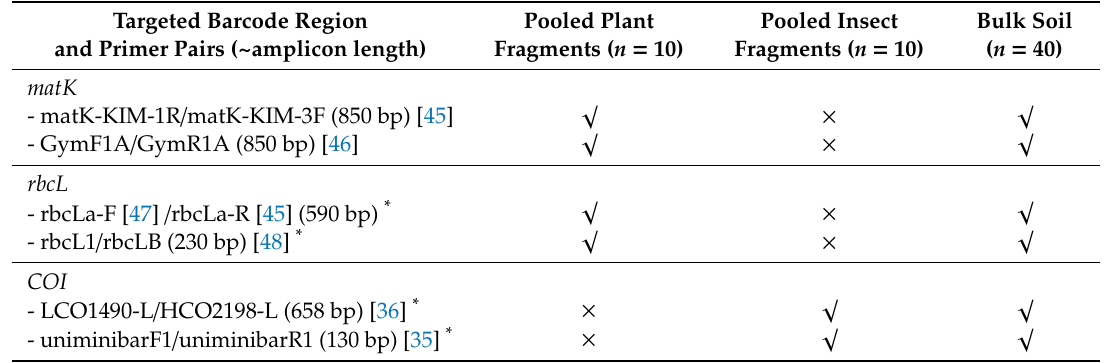
Table 1. Barcoding loci amplified from pooled fragment (plant and insect) and bulk soil DNA. Primer pairs used per region are